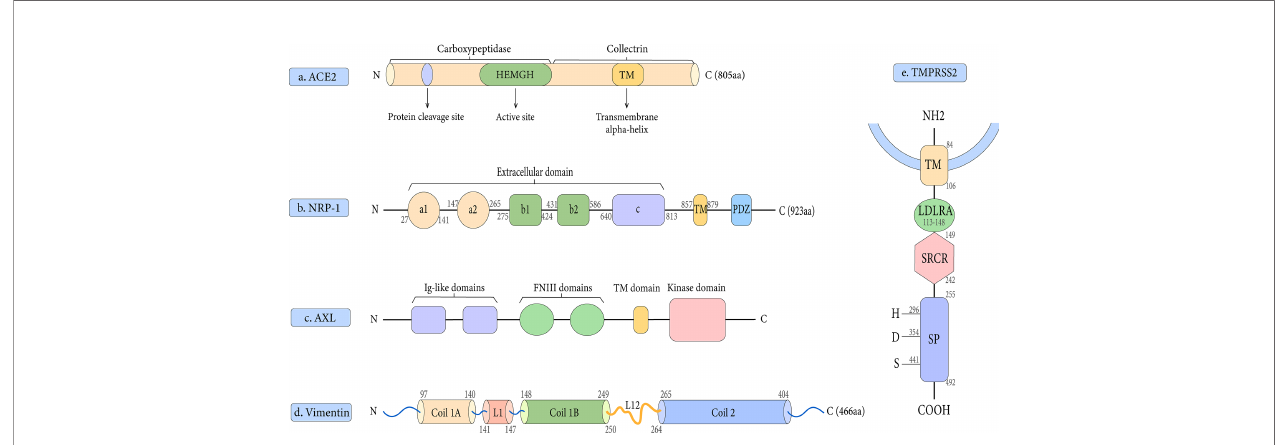
FIGURE 2 | Schematic representation of the structures of the receptor and host proteases. (A) The structure of ACE2. (B) The structure of NRP-1. (C) The structure of AXL. (D) The structure of Vimentin. (E) The structure of